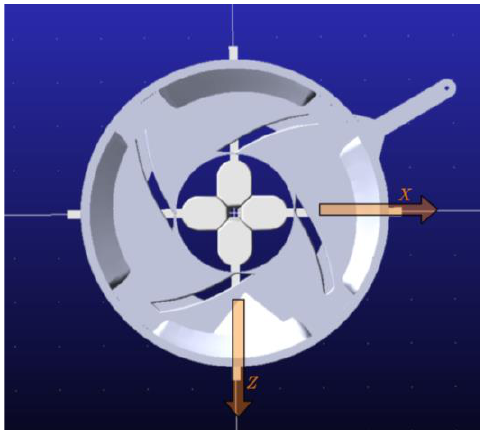
Figure 18. ADAMS View diagram of the coordinate system of the opening mechanism.